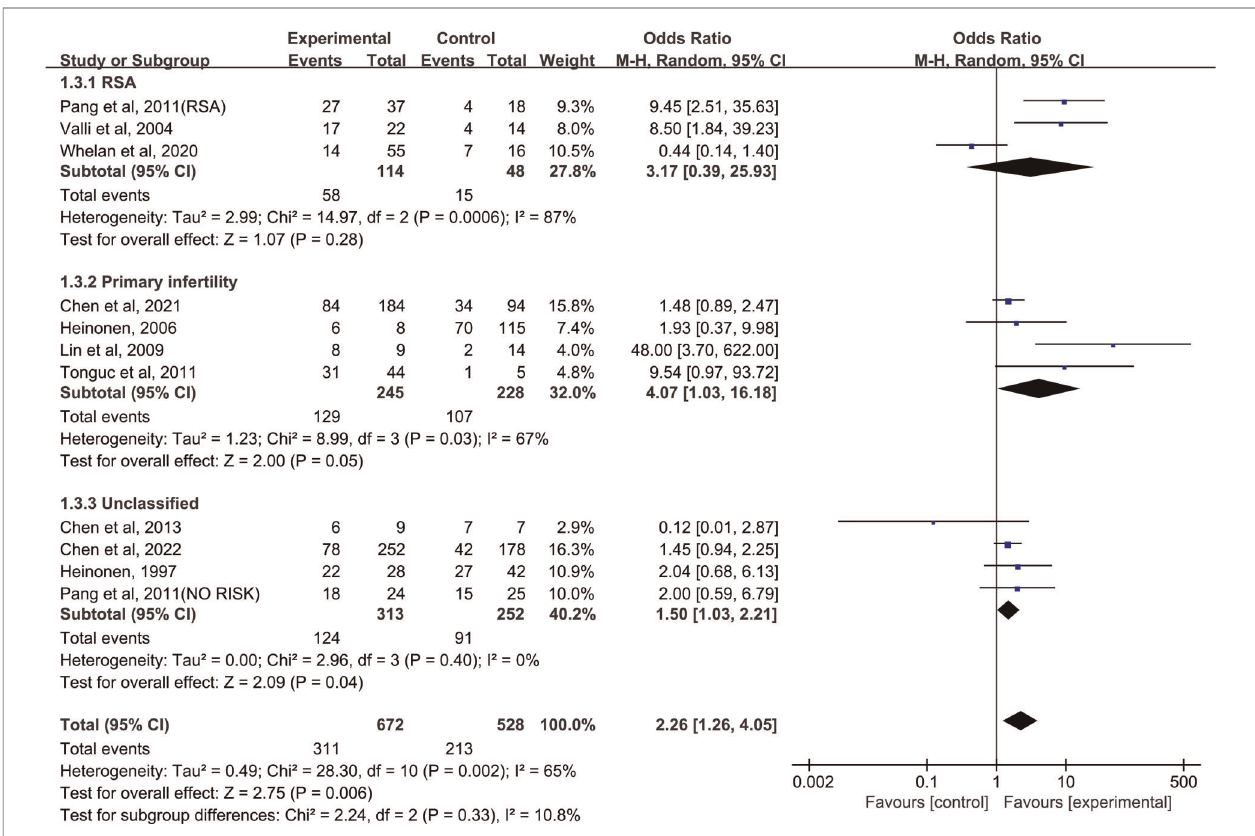
FIGURE 4 | Forest plot of term delivery for treatment with hysteroscopic metroplasty group versus untreated